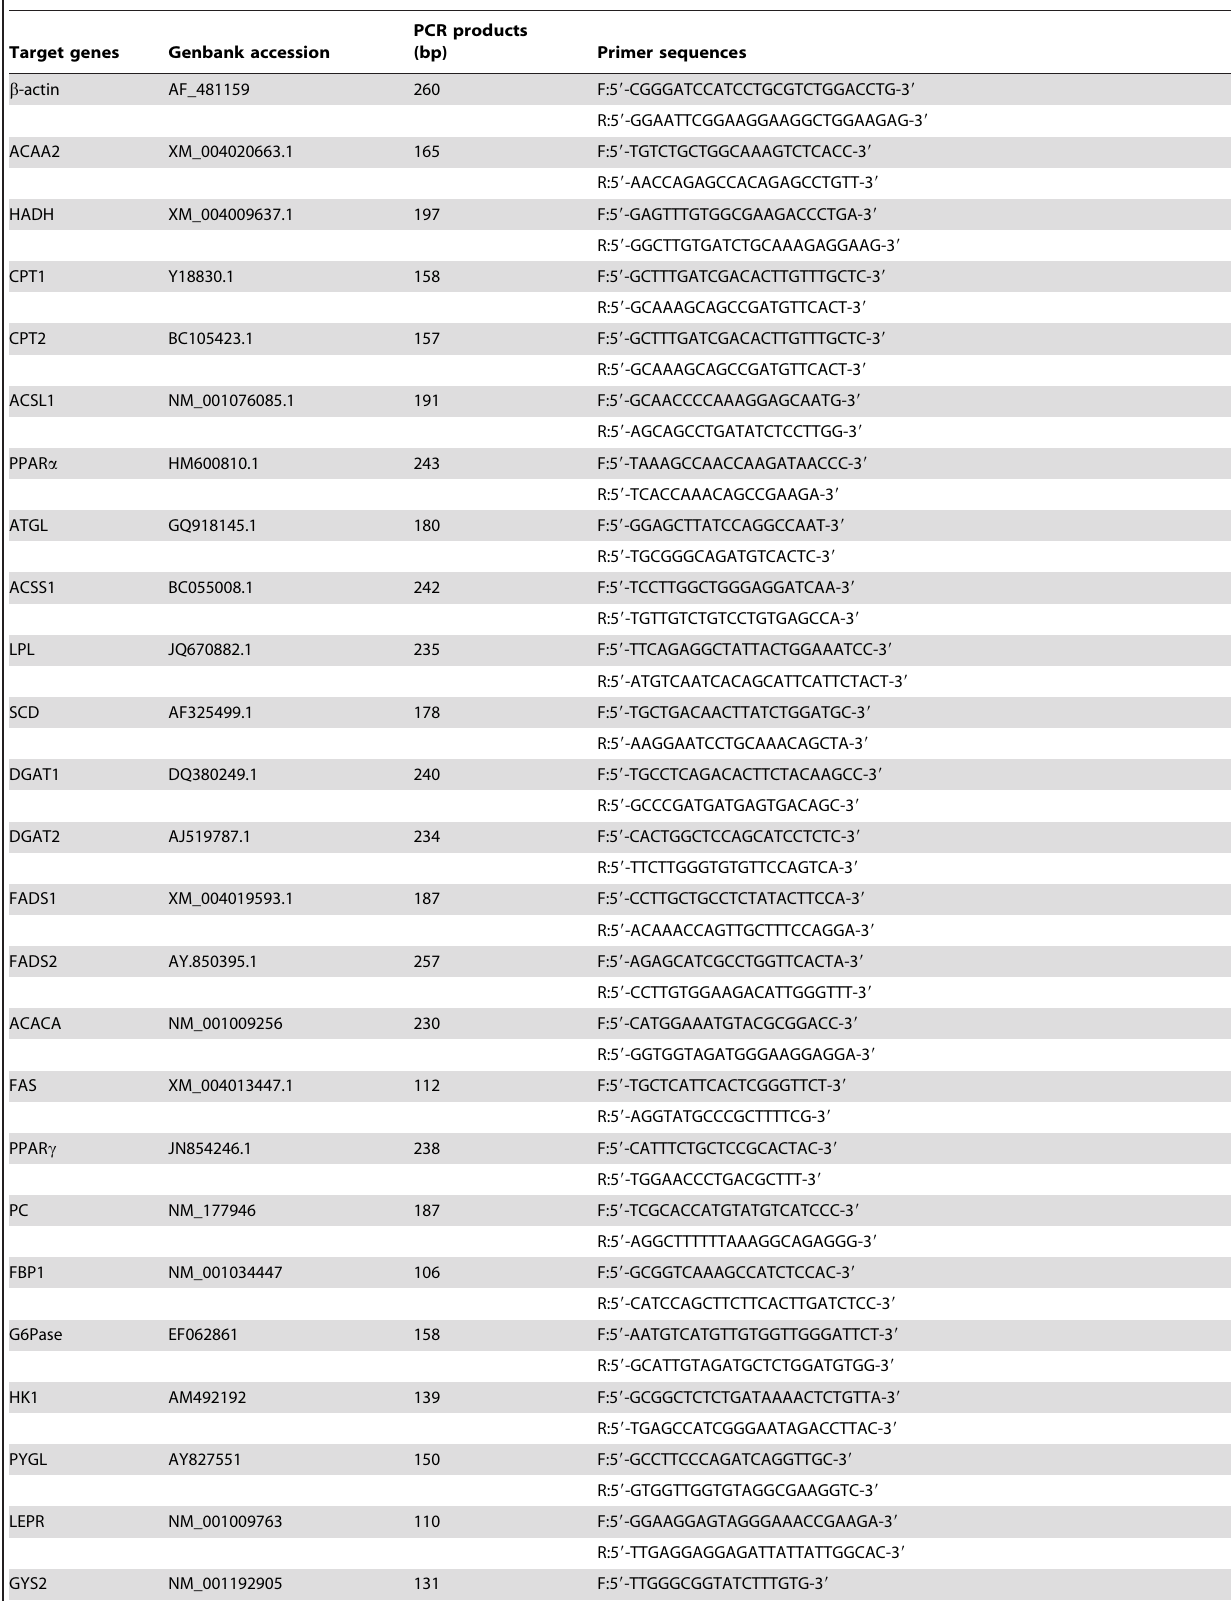
Table 6. PCR primers for immunity and stress, lipid metabolism and carbohydrate